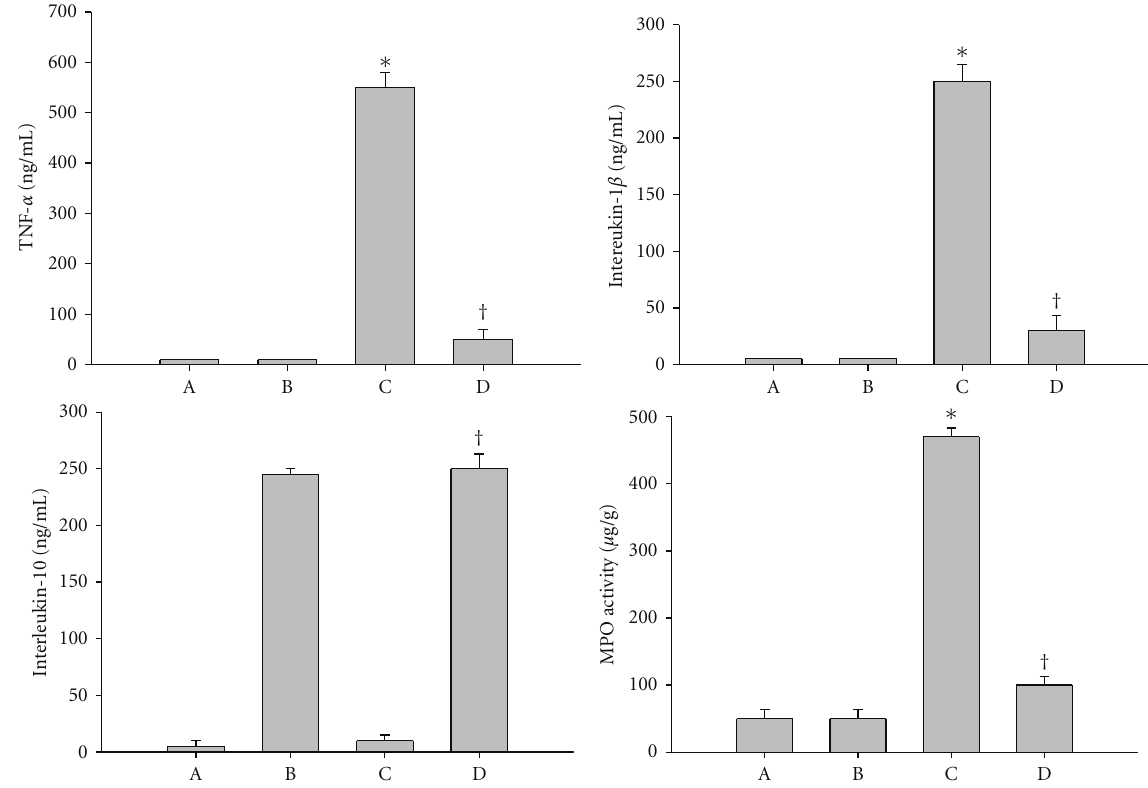
Figure 3: E ff ects of heat exposure (42 . 4 ◦ C for 1 hour) on hypothalamic levels of tumor necrosis factor- α (TNF- α ), interleukin-1 β , interleukin-10 and myeloperoxidase (MPO) of normothermic mice received normobaric air (A), normothermic mice received hyperbaric oxygen (B), heatstroke mice received normobaric air (C), and heatstroke mice received hyperbaric oxygen (D). ∗ P < . 01 compared with corresponding control values in group (A). † P < . 01 compared with corresponding control values in group (C). Bars are mean ± SE of eight mice per group. Samples were obtained at 4 hours after the termination of 1-hour heat exposure or the equivalent time for the normothermic controls. Table 4: Mean ( ± SE) number of iNOS-positive cells per hypothalamic section for di ff erent groups of mice ( n = 8 per group). Treatment